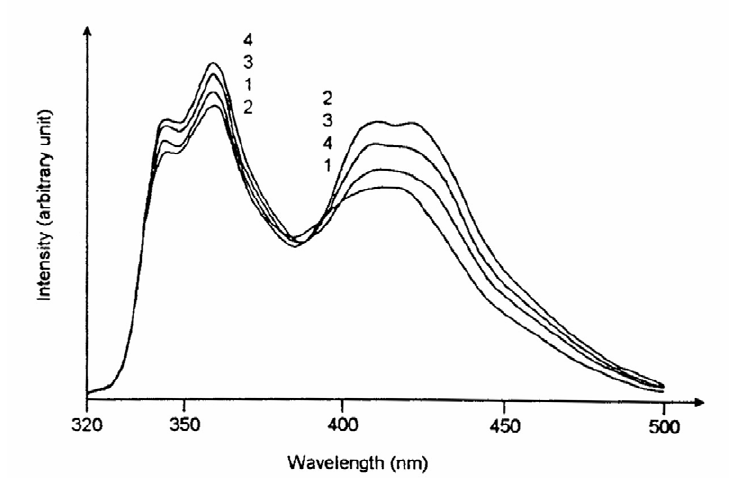
Figure 10. Steady state fluorescence spectra of CAZL in different aqueous environments at pH 12: (1) in water, (2) in 5mM β -CD, (3) in 5mM β -CD plus 1M urea and (4) in 5mM β -CD plus 2M urea. CAZL concentration is same in all the cases.